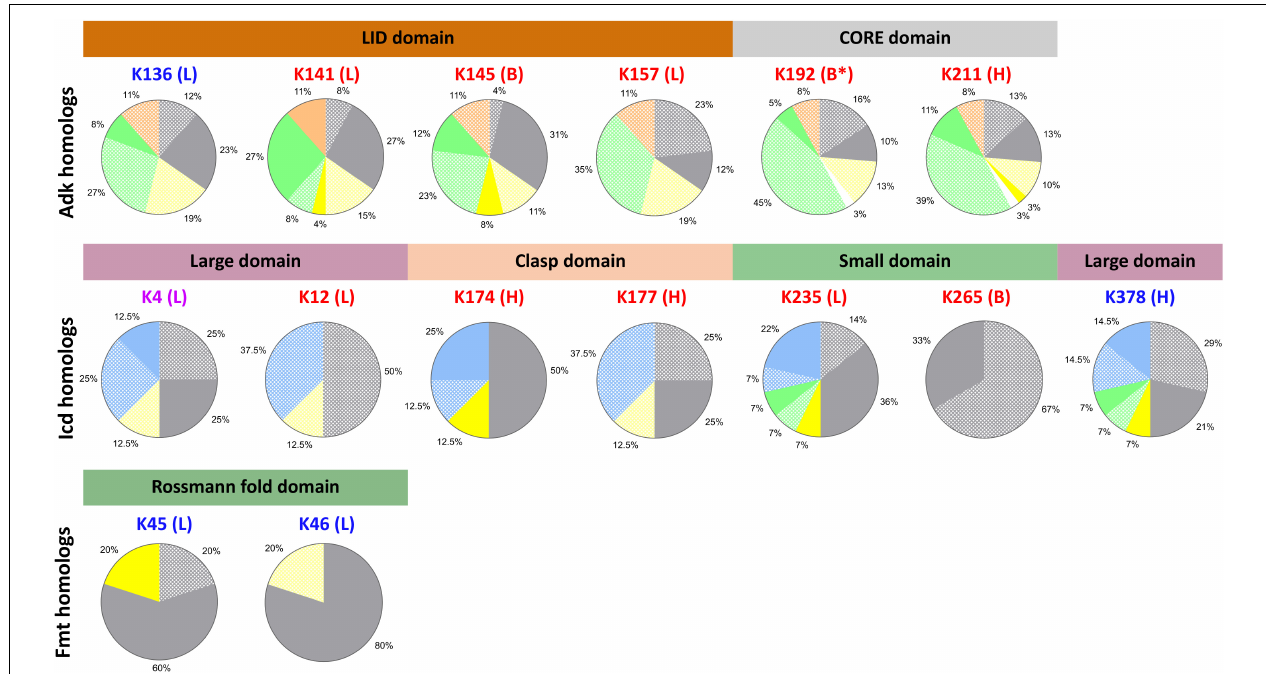
FIGURE 7 | Residue conservation in KAT substrate protein homologs by domain of life based on presence of 3D structural domains. Each lysine residue previously identified as acetylated in E. coli K-12 by AcP and KATs on Adk, Icd, and Fmt proteins are shown above individual pie charts. The color of the lysine residue corresponds to the type of acetylation: AcP (red), KAT (blue), AcP and KAT (purple). The letters in parentheses indicate the type of secondary structure on which the residue was found in the E. coli substrate proteins: loop (L), alpha helix (H), beta strand (B). Stars indicate the lysine was located on the end of the type of secondary structure. The structural domains for each protein are shown with colored bars and are colored according to domains in Figure 1 . Pie charts show the conservation of lysine residue by domain of life when structural domains of the protein homologs are taken into account. Protein homologs from Gram-negative, Gram-positive, and Gram-variable bacteria are colored gray, yellow, and white, respectively. Eukaryotes are green, Archaea are blue, and synthetic constructs are orange. Solid colors indicate the lysine residue was conserved and dot patterns indicate the lysine residue was not conserved. Only proteins that had the structural domain present were used to calculate lysine residue